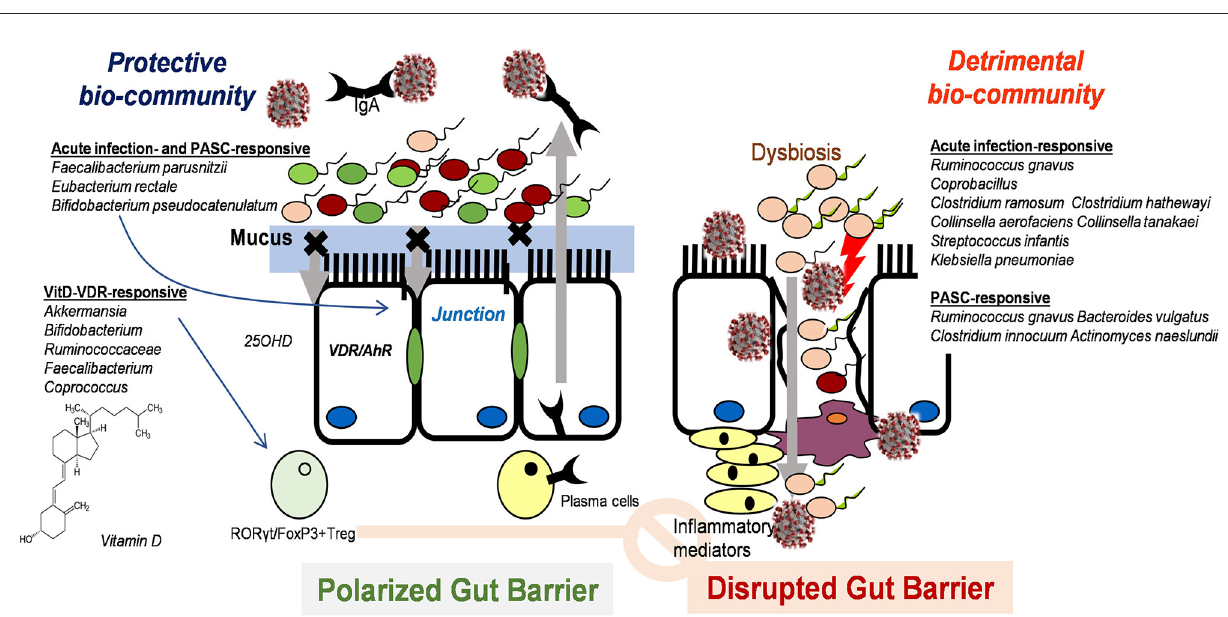
FIGURE3 Postulated scheme of vitamin D-induced intervention against SARS-CoV-2 infection in the gut mucosa via modulation of microbiota and subsequent immune